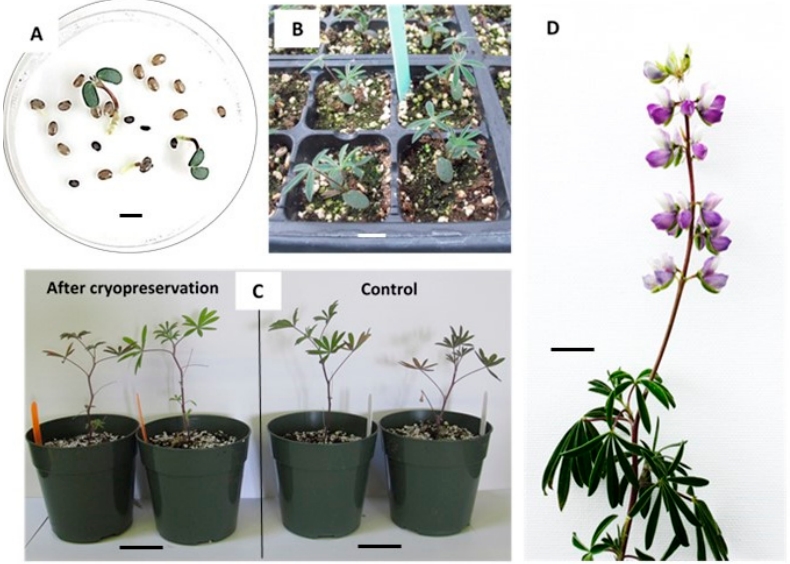
Figure 4. In vitro germination of cryopreserved seeds and growth of Lupinus rivularis on filter paper ( A ) bar = 1 cm; and in the greenhouse after three months ( B ) bar = 1 cm; Seedlings developed from cryopreserved and non-cryopreserved (control) seeds in the greenhouse after six months, bar = 3 cm ( C ); and flowering observed in the greenhouse after nine months ( D ) bar = 3 cm. Table 2. Morphological traits and chlorophyll content in leaves of plants developed in a green- house from control and cryopreserved seeds of two different lots.